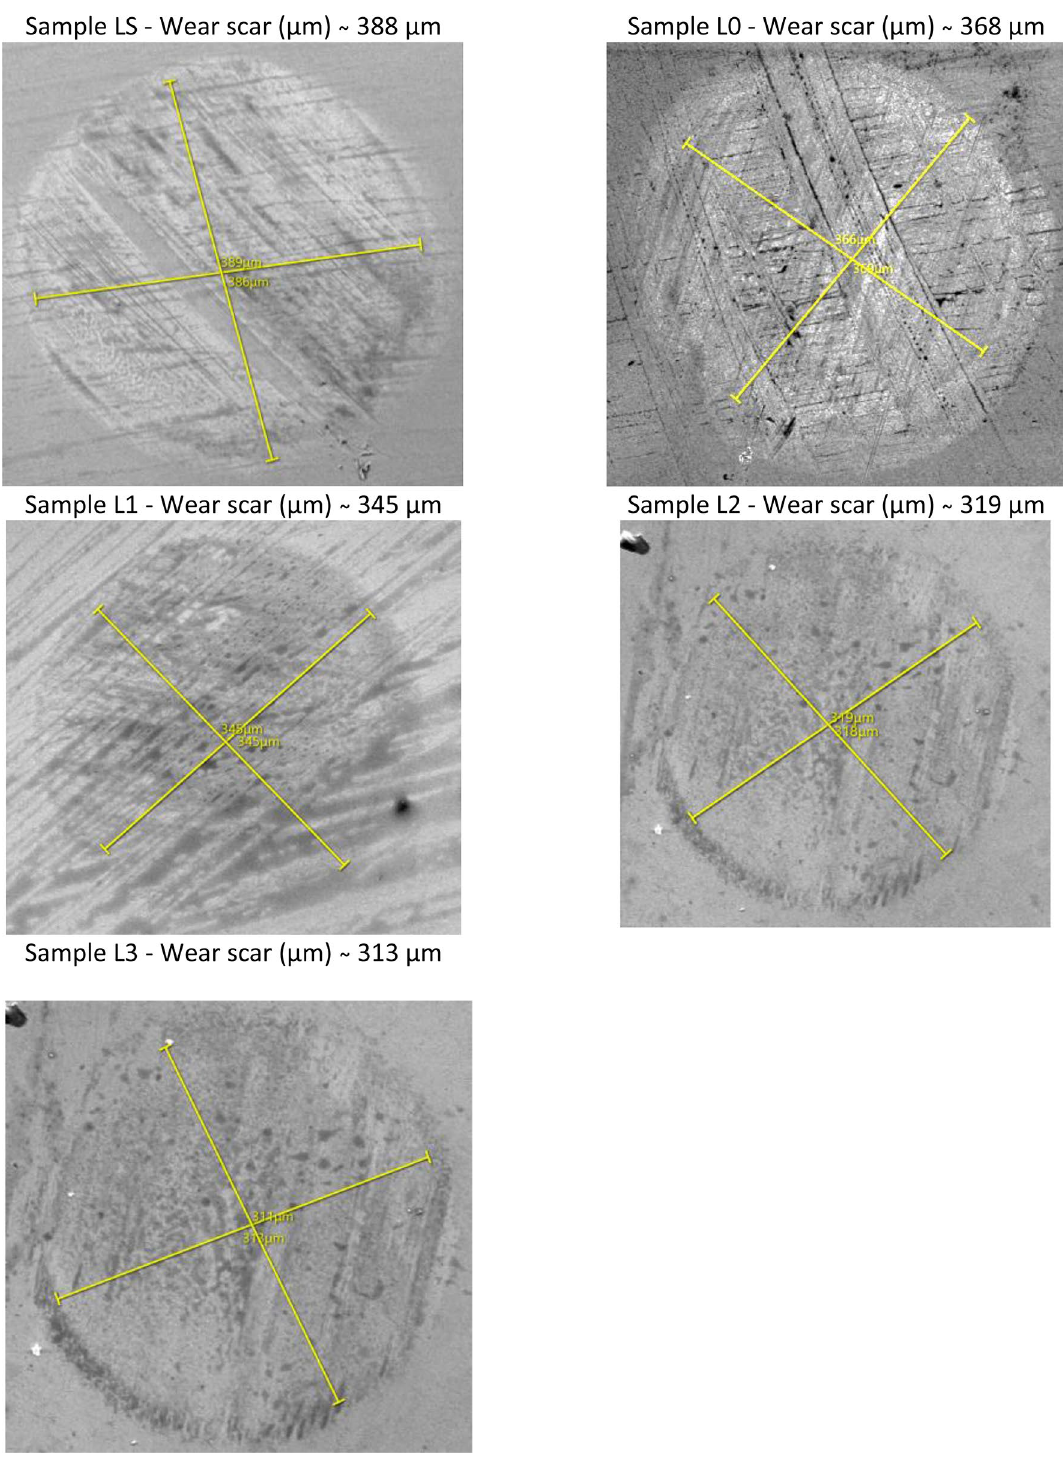
Figure 6. SEM images of worn-out samples corresponding to pure base oil and additive 0.01, 0.25, 0.050 and 0.075 wt.% TiO 2 at RT, 396 N load at 1200 rpm after a 30-min period of